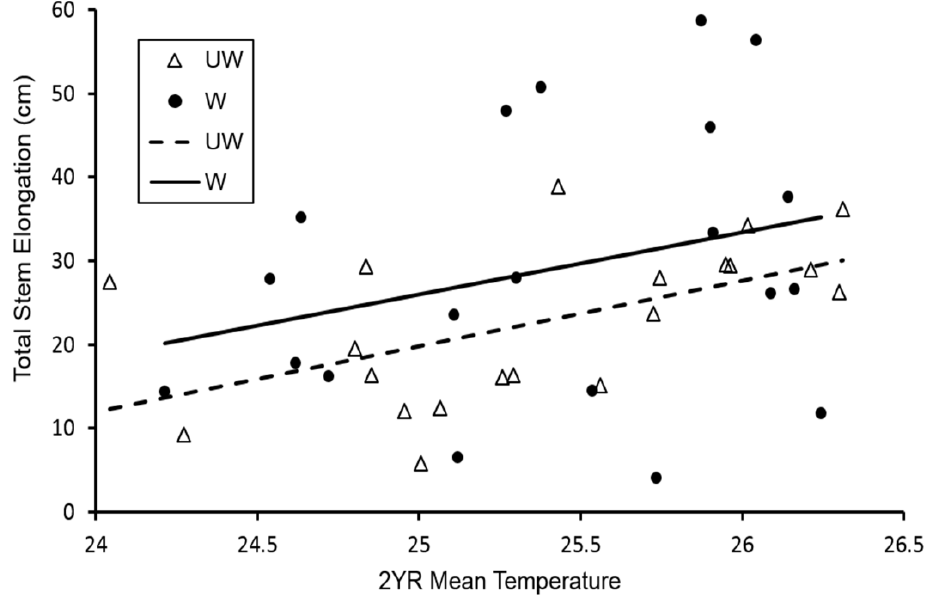
Figure 3. Regression plot of two-year mean tree canopy temperature regressed with total stem elongation per tree for each watering treatment. W = watered and UW = unwatered trees.